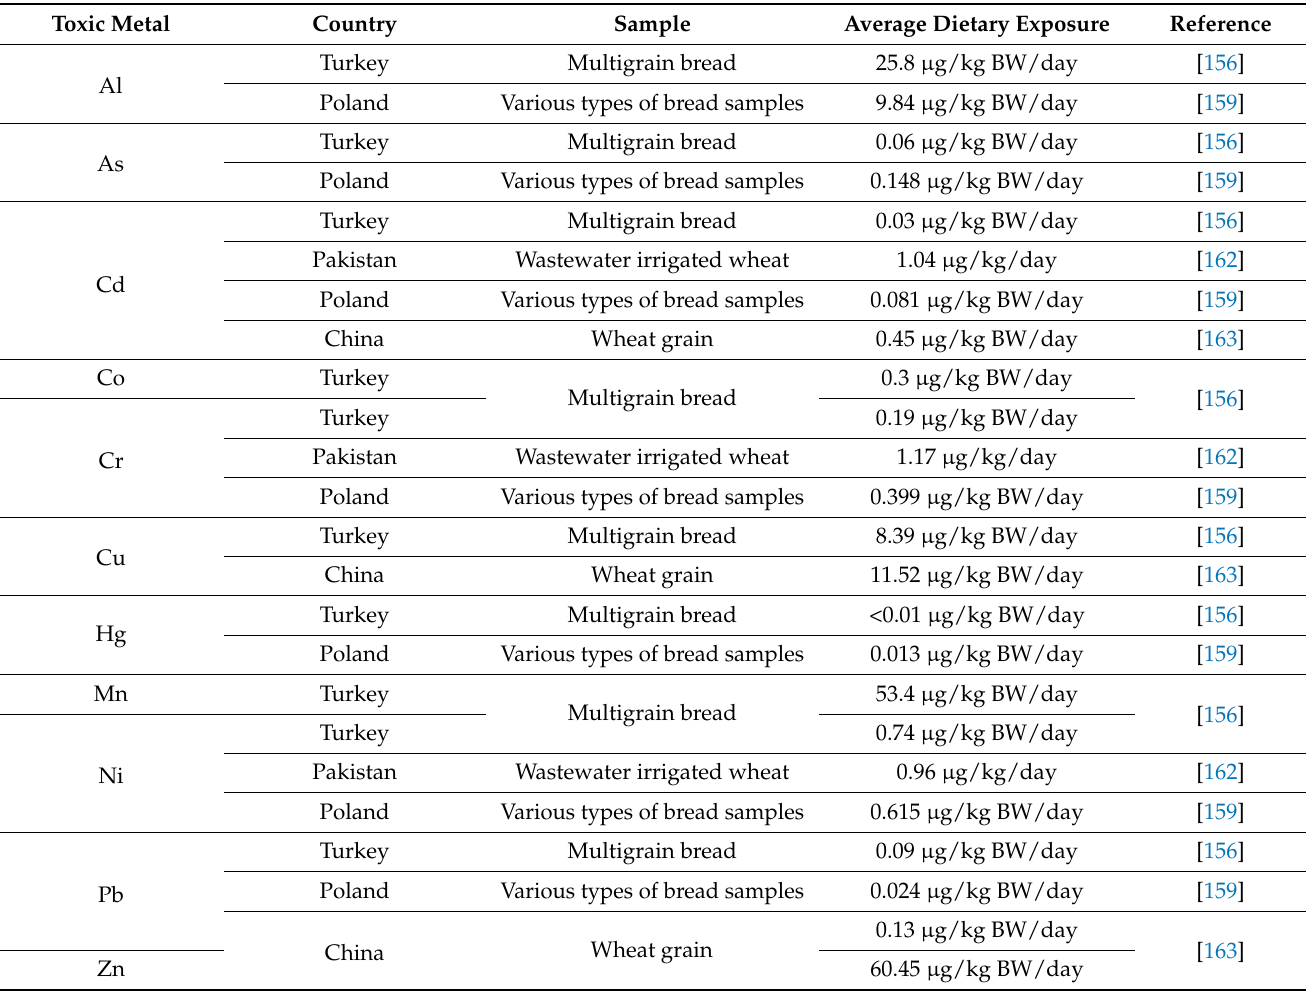
Table 6. Dietary intake of toxic metals in wheat and wheat-based products in various